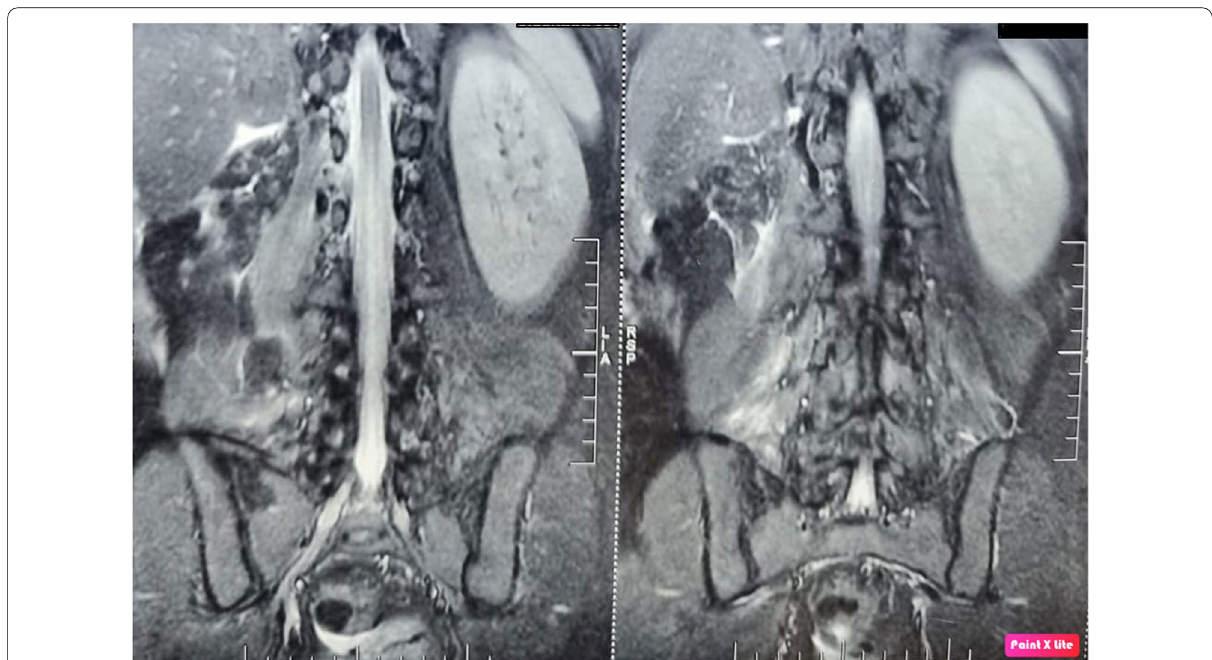
Fig. 5 Follow-up MRI image at 6 months showing no evidence of